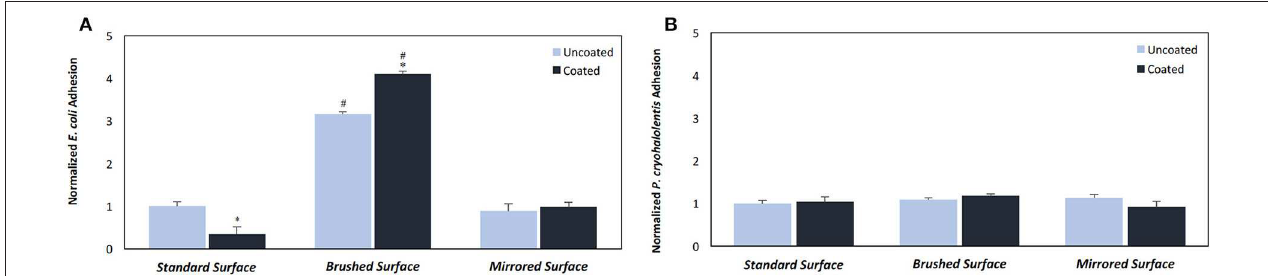
FIGURE 6 | Bacterial adhesion on coated and uncoated SS coupons for (A) E. coli and (B) P. cryohalolentis . Coatings were created in pH 7.4 and 21 ◦ C with a CT = 24h. Normalized bacterial adhesion of (A) E. coli to the surface of 316L SS coupons after incubating in a bacterial solution for 5h and (B) P. cryohalolentis to the surface of 316L SS coupons after incubating in a bacterial solution for 24h. # A significant difference from the respective standard surface finish ( p < 0.05); *A significant difference from the respective uncoated surface ( p < 0.05) using a standard one-way ANOVA t -test.